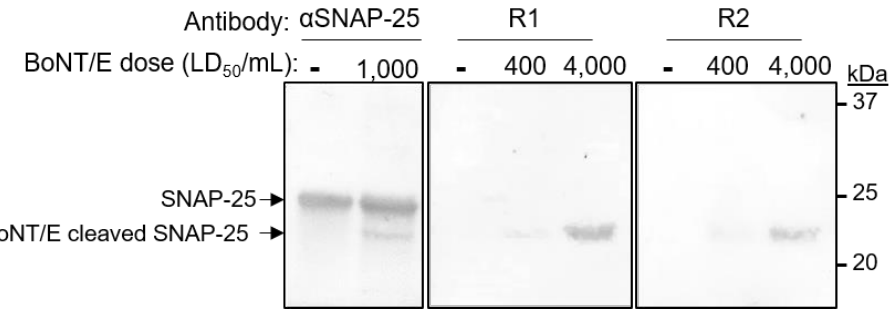
Figure 2. Specificity of an immunized rabbit’s sera. Differentiated SiMa cells were exposed to 0, 400 or 4000 LD 50 /mL of BoNT/E and lysed 24 h after intoxication. Lysates were subjected to SDS-PAGE and Western-blotted using either anti-SNAP-25 polyclonal antibody or Bio-P1 immunized rabbits (R1 and R2).